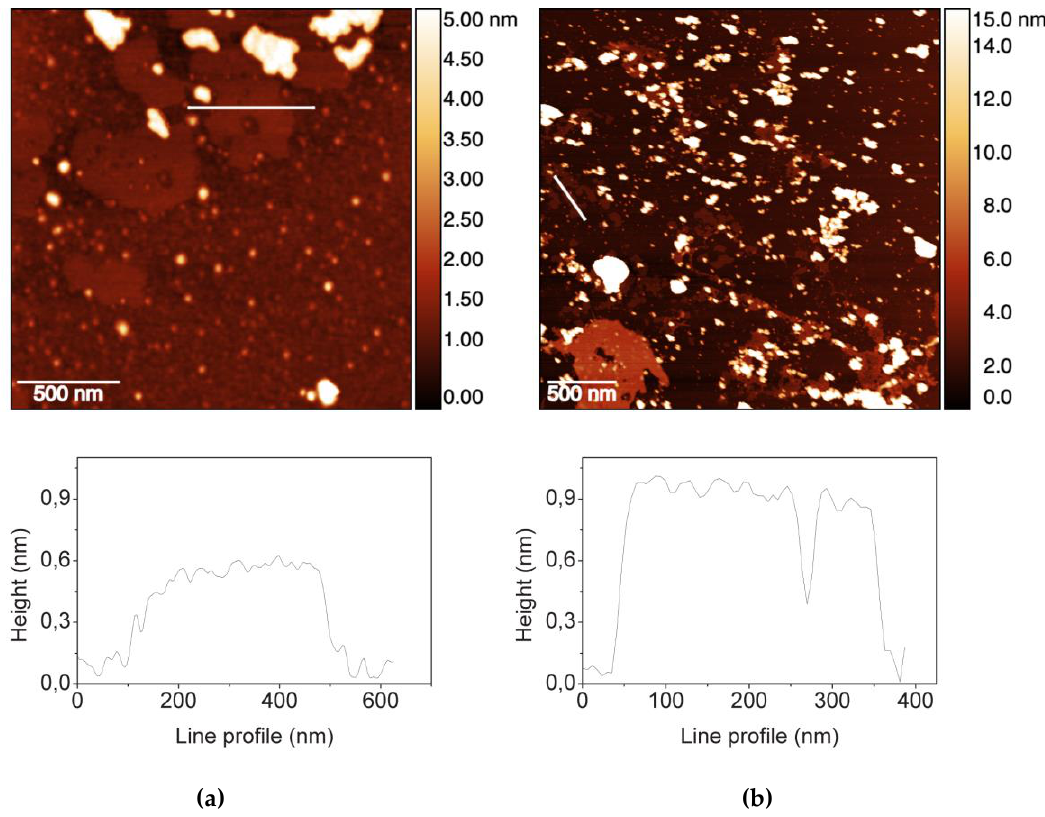
Figure 1. Atomic Force Microscopy (AFM) topographies of: ( a ) GO_LiClO 4 sample (GO exfoliated ); ( b ) commercial GO product (GO sigma ) and related height profiles.